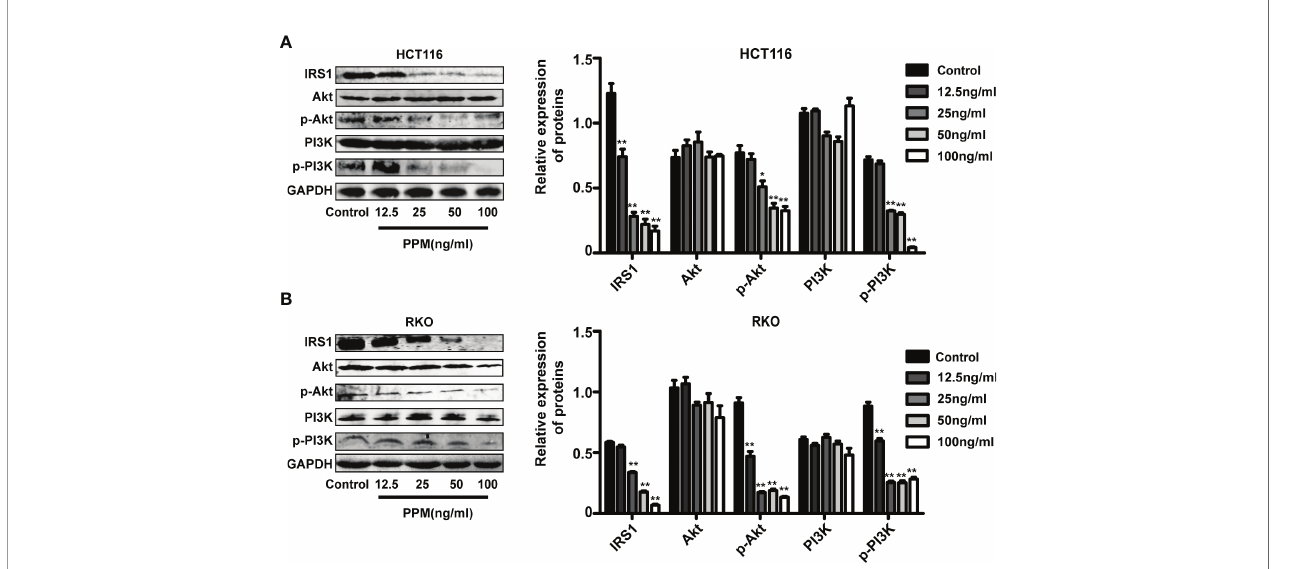
FIGURE 6 | Periplocymarin (PPM) modulates gene expression involved in PI3K/AKT signaling pathway. PPM treatment altered the expression levels of IRS1, PI3K, AKT, p-PI3K, and p-AKT in HCT 116 (A) and RKO cells (B) . Values are shown as means ± SEM. * P < 0.05, ** P < 0.01, vs . untreated control group.